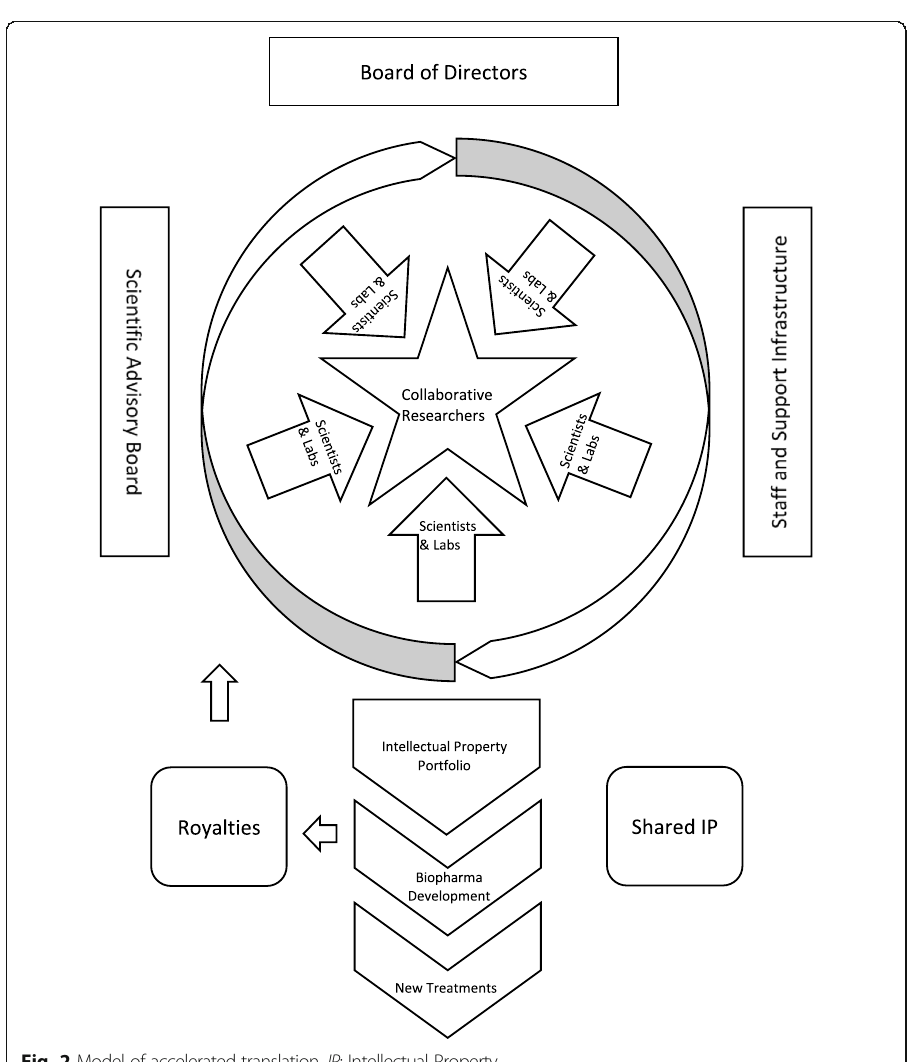
Fig. 2 Model of accelerated translation. IP : Intellectual Property Notes: Based on The Myelin RepairFoundation